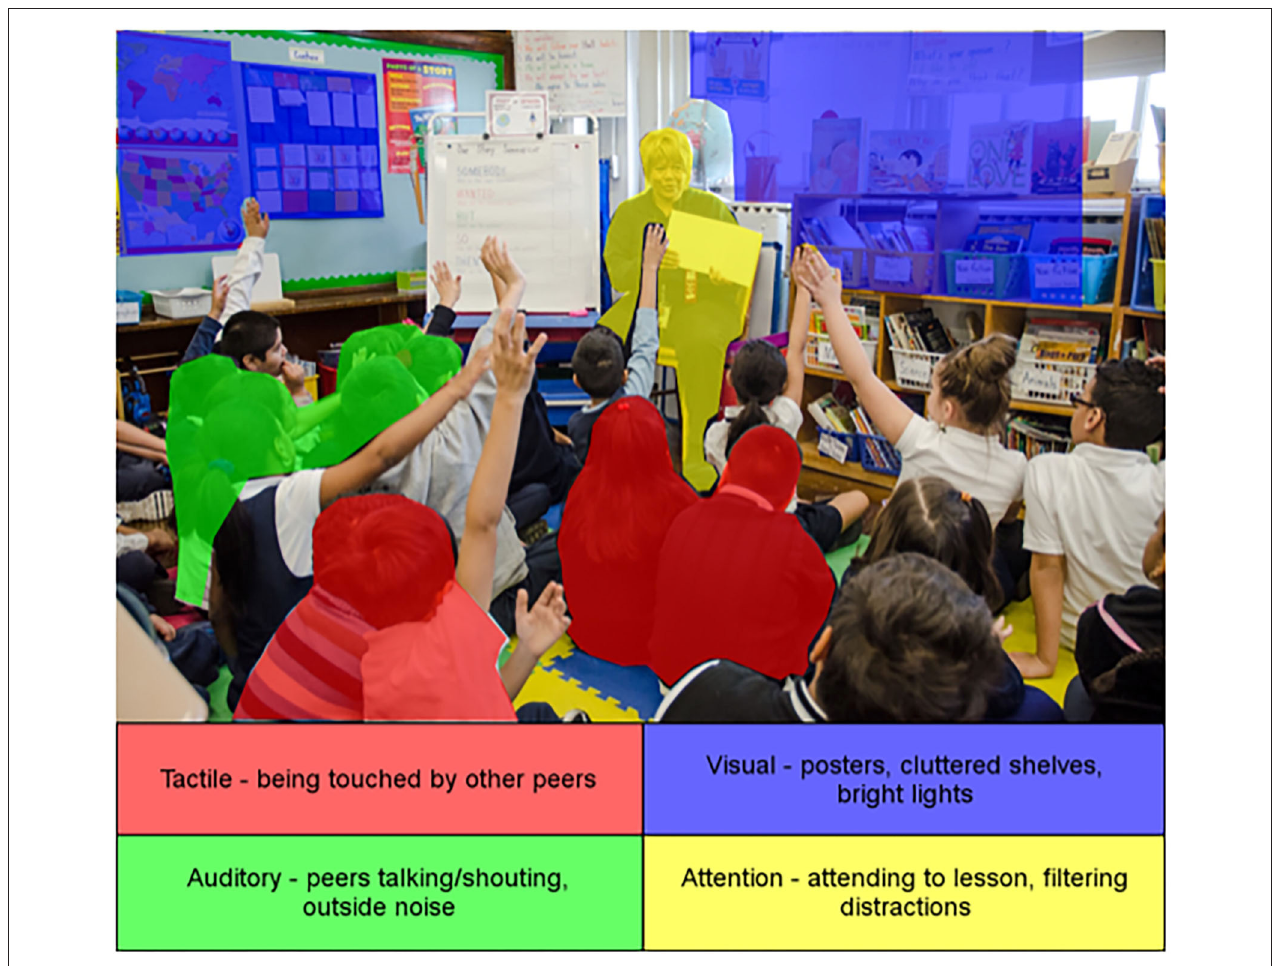
FIGURE 1 | Example of the sensory and attentional demands that may be present in a classroom environment. Reproduced from